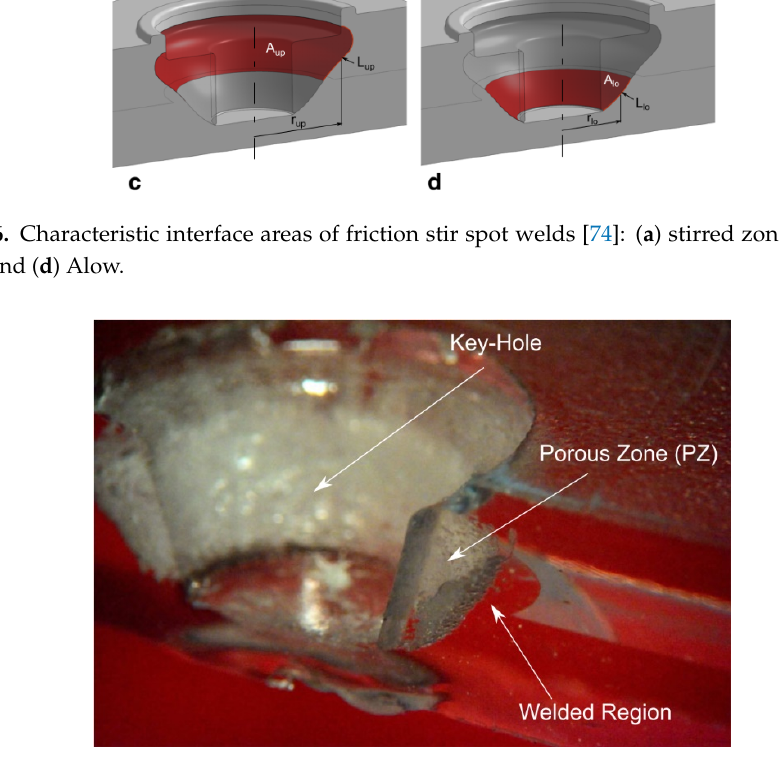
Figure 27. Presence of porous region at the interfaces between the stirred region and upper and lower sheets [77].